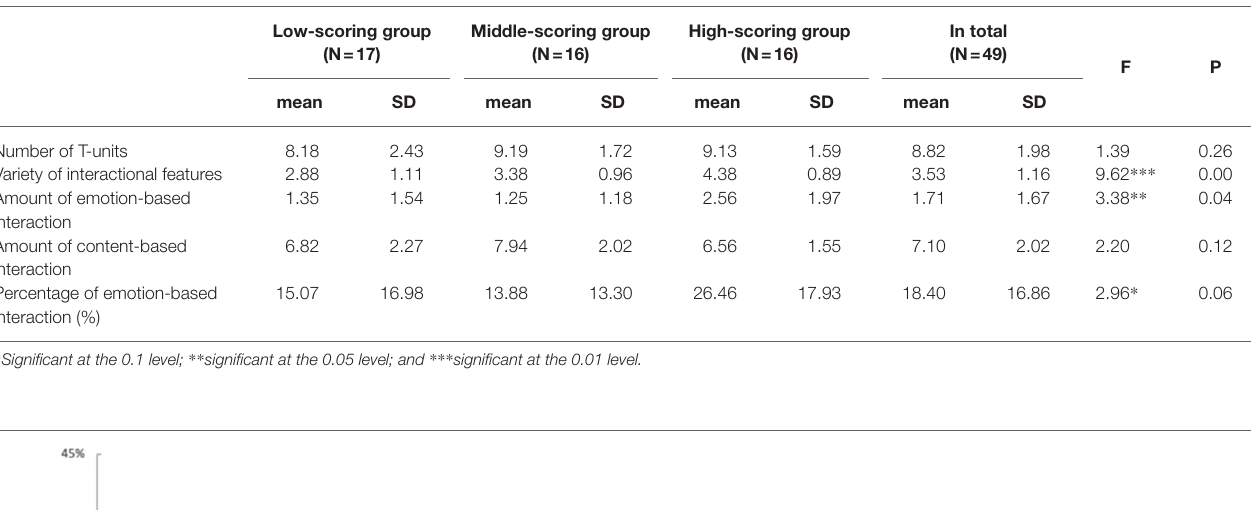
TABLE 5 | ANOVA of interactional features among the three groups.